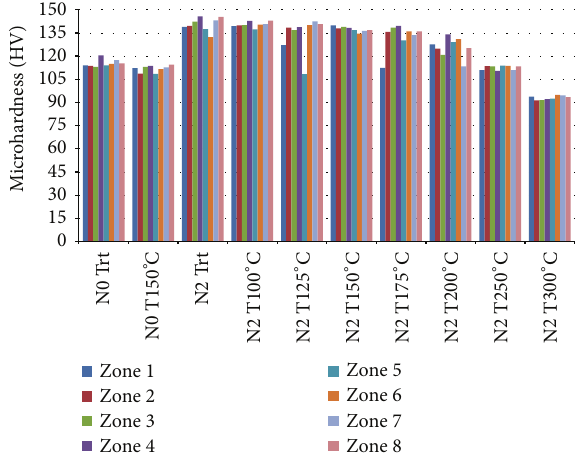
Figure 4: Microhardness values obtained at the defined zones of the AA-5083 straight blade for the isothermal forging tests carried out at different temperature values (where “rt” means room temperature, “N0” means the use of nonsubmicrometric grain size AA-5083 as starting material, and “N2” means the use of AA- 5083 submicrometric structure obtained by ECAE twice as starting material).